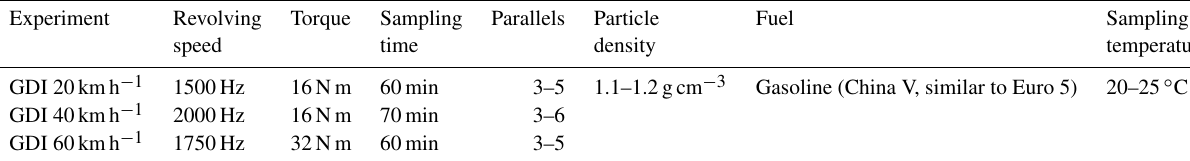
Table 1. Descriptions of vehicle exhaust and sampling procedures. Experiment Revolving Torque Sampling Parallels